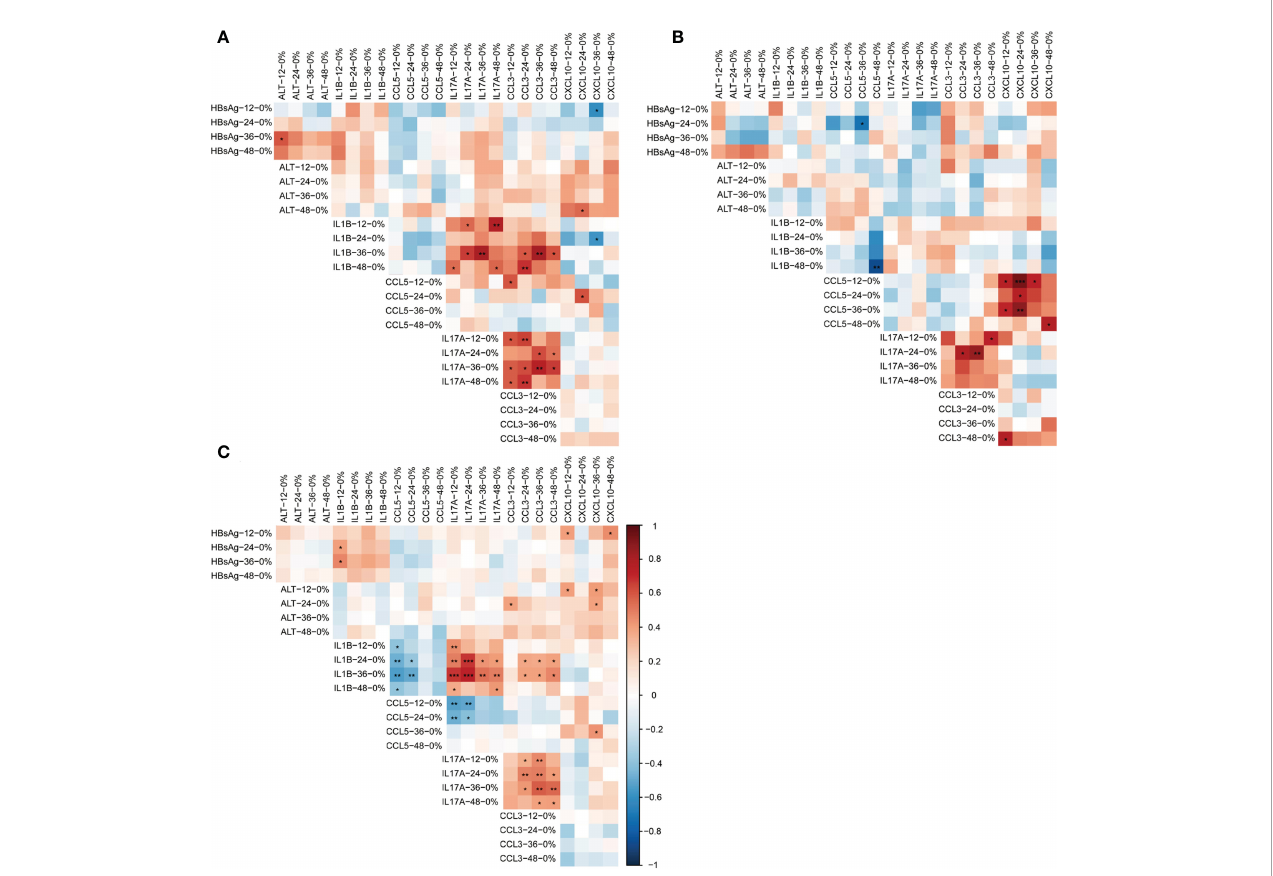
FIGURE 3 Correlation between dynamic changes of HBsAg, ALT and cytokines in different response to the add-on therapy. (A) Correlation between dynamic changes of HBsAg, ALT and cytokines in complete responders (B) Correlation between dynamic changes of HBsAg, ALT and cytokines in partial responders (C) Correlation between dynamic changes of HBsAg, ALT and cytokines in non-responders. * P <0.05; ** P <0.01. HBsAg, hepatitis B surface antigen; ALT, alanine aminotransferase; Add-on, nucleos(t)ide analogs combined with peg-interferon alpha therapy; complete responder, achieving HBsAg loss at week 48; partial responders: achieving HBsAg decreased by > 1 log from baseline but HBsAg remain positive at week 48; non-responder, achieving HBsAg decreased by < 1 log from baseline and HBsAg remain positive at week